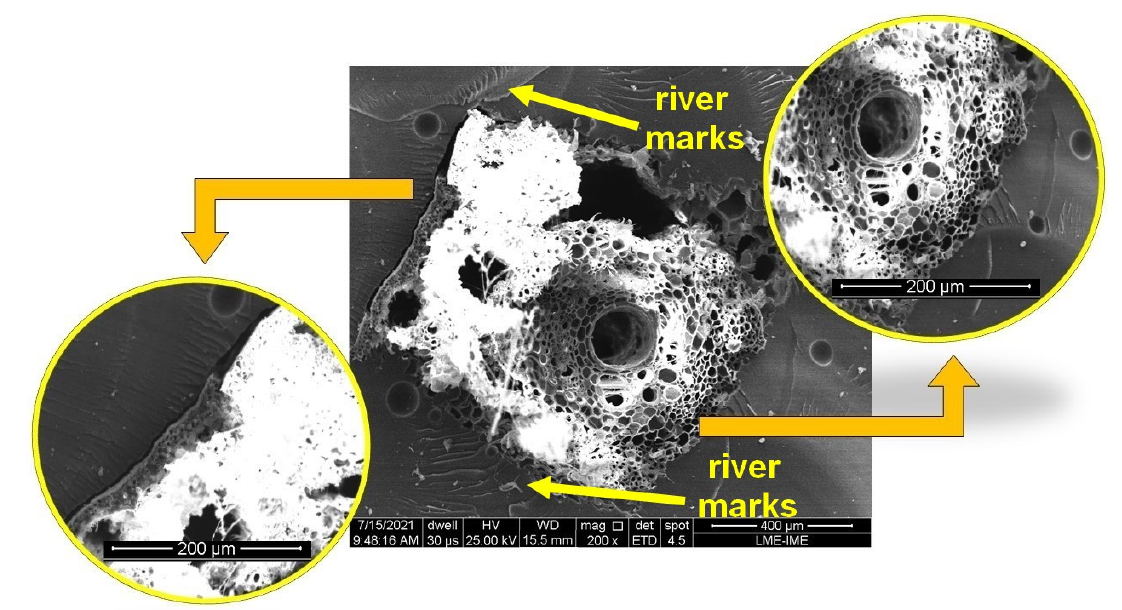
Figure 6. SEM images of the fiber-matrix interface of the 30 vol% epoxy-caranan composite after the Izod impact test.